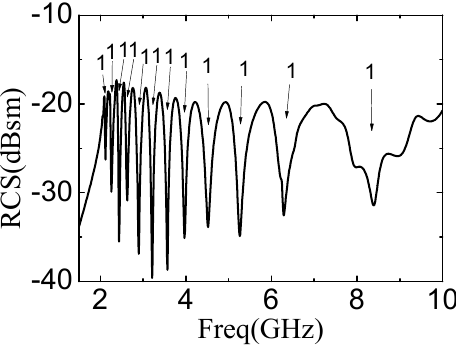
Table 1. Key geometry parameters of 12 ‐ bit ‐ tag printed on F4BM substrate.